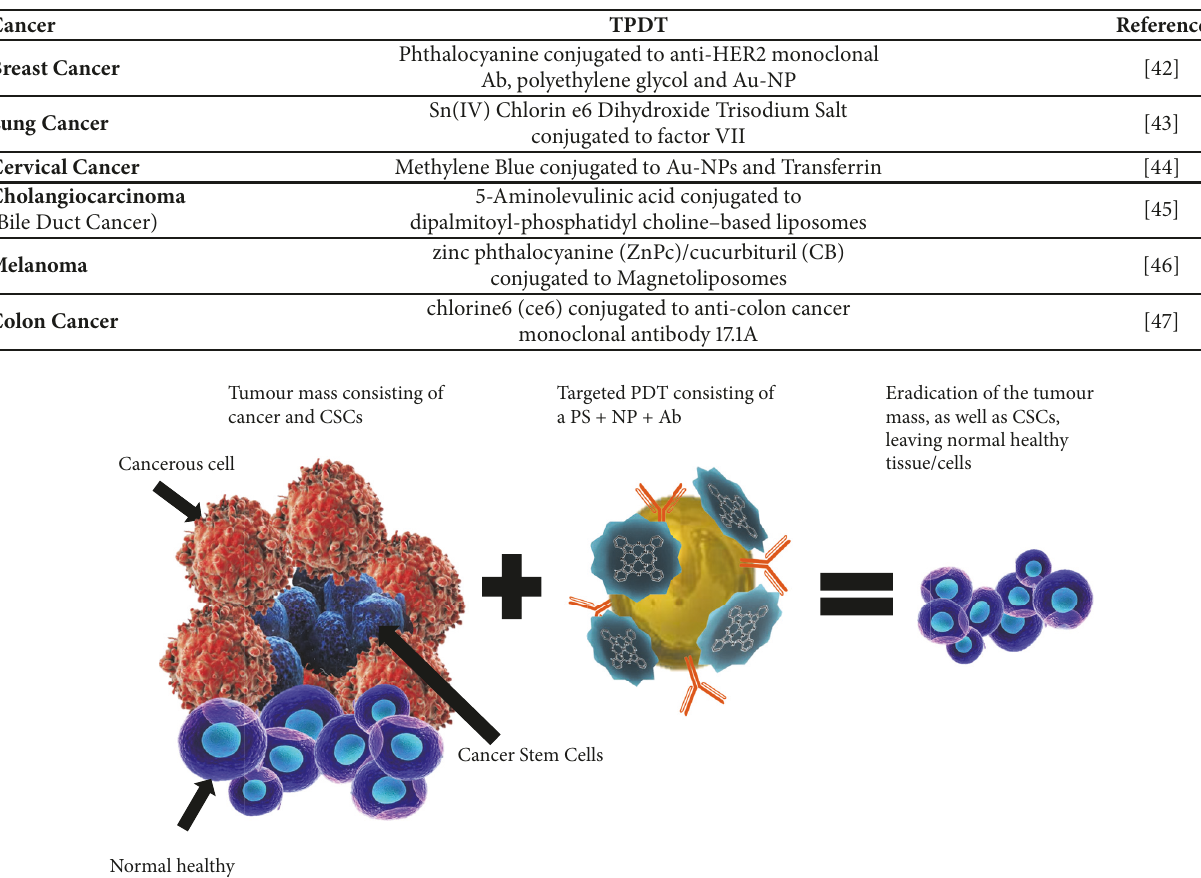
Table 3: Cancer and TPDT.